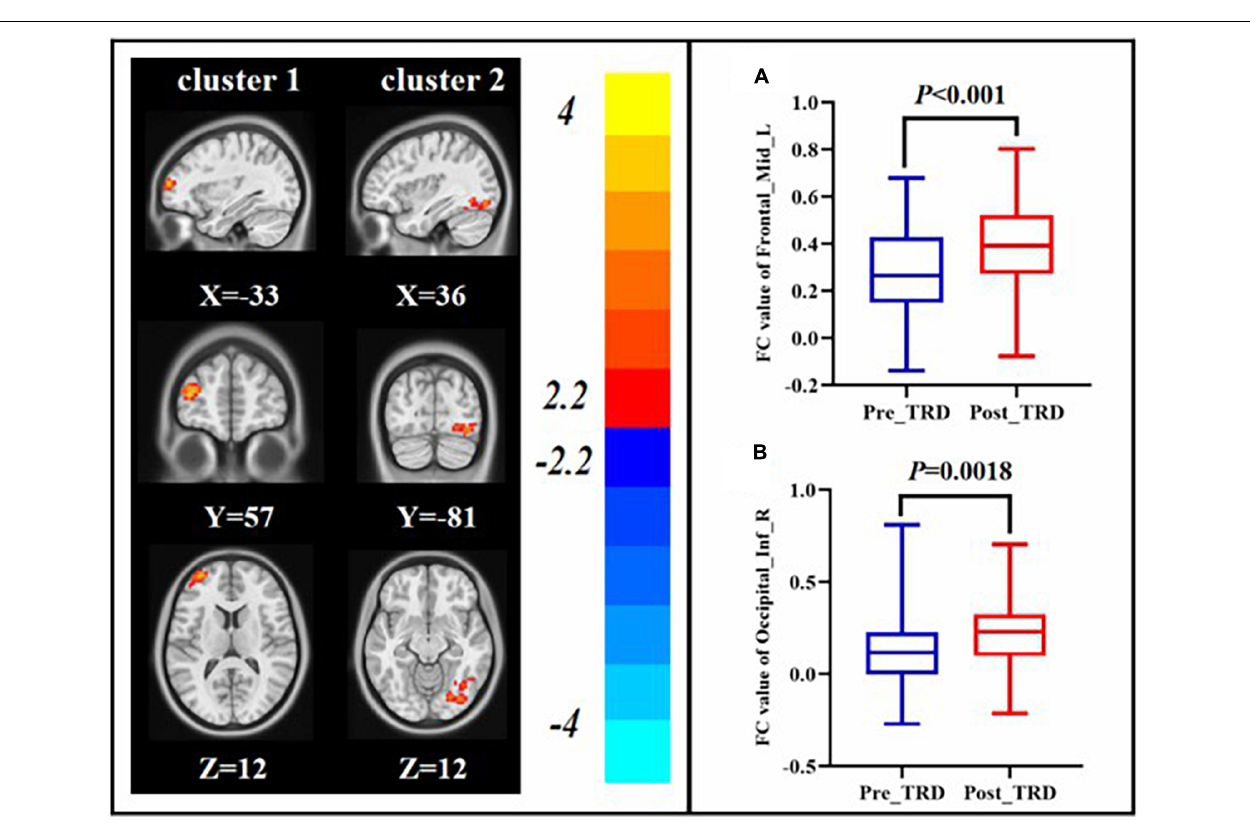
Frontiers in Psychiatry |